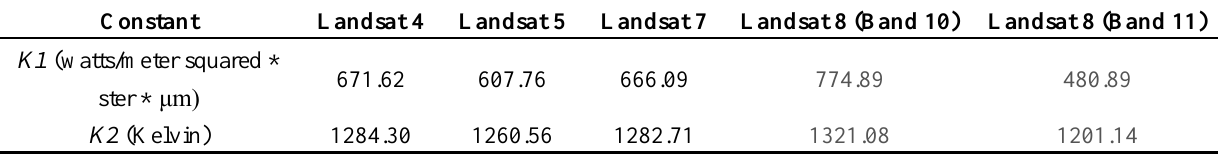
Table 2. Constants K1 and K2 for the Landsat satellites.